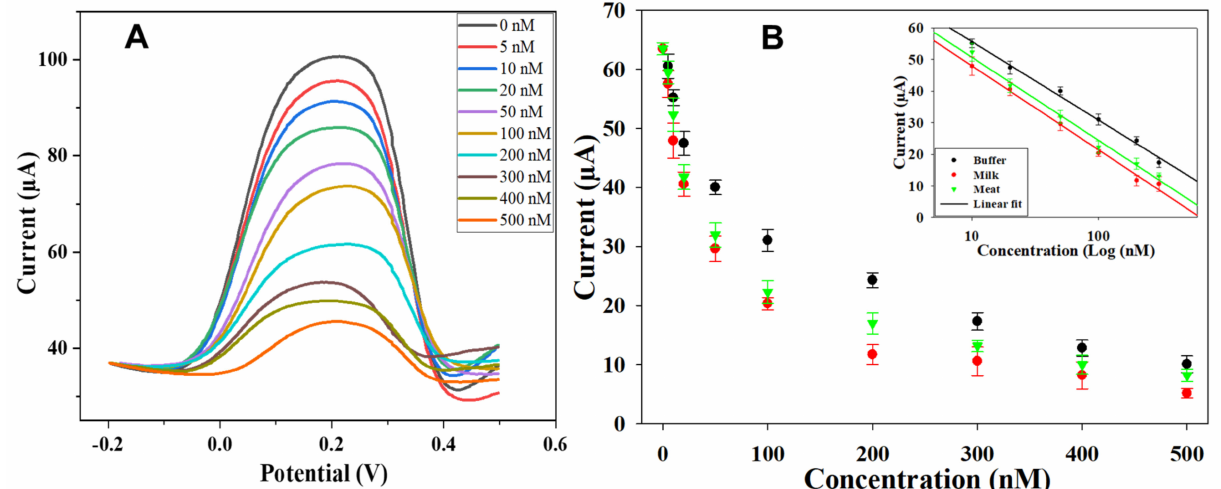
Figure 6. Sensitivity test of the sensor: ( A ) the DPV curves for different TC concentration in acetate buffer; ( B ) the calibration curves extracted from the DPV curves heights (inset: linear range of the sensors). The calibration curves were realized on the basis of the generated current (DPV) versus the TC concentrations, as indicated in Figure 6B. Each point in the calibration curve represents an average of five measurements ( n = 5) at each concentration of the TC. The working range for acetate buffer, milk, and meat samples was between 5 to 500 nM as indicated in Figure 6B. We found a linear regression between the logarithm of the TC concentration and the generated current in the range 10 to 300 nM (inset of Figure 6B), as expressed